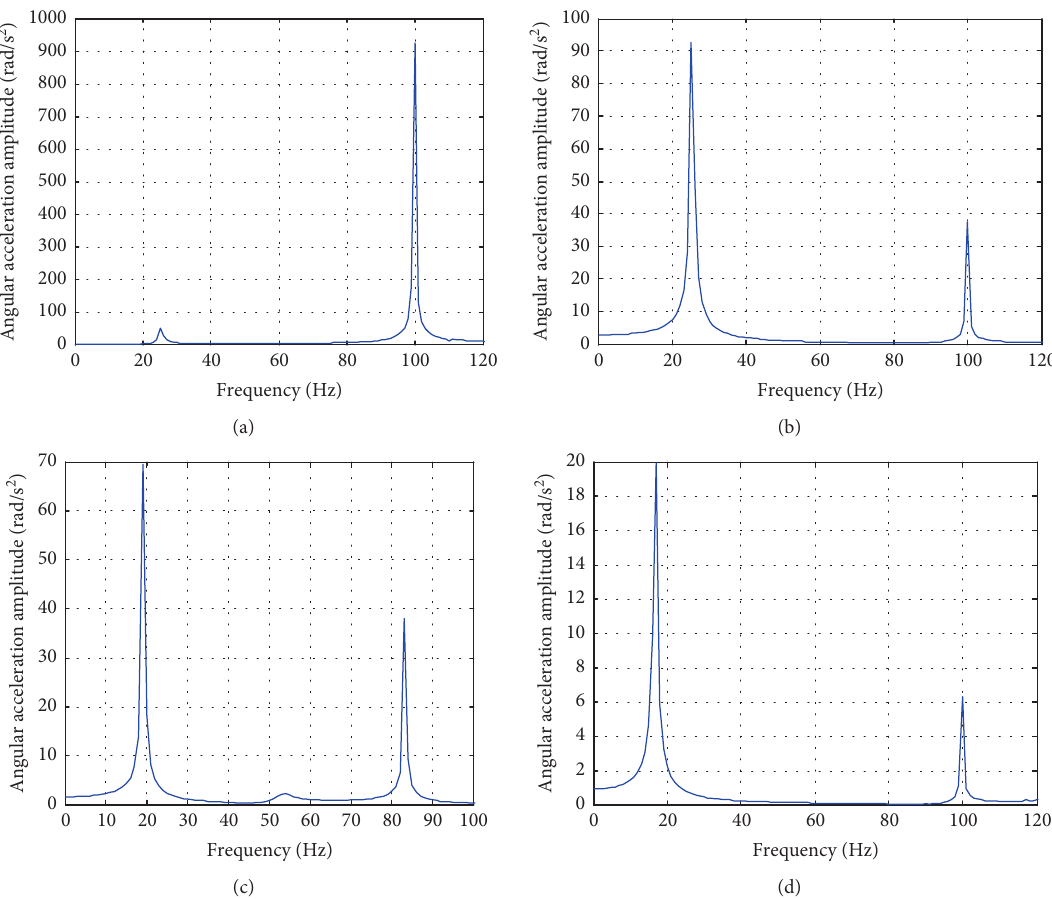
Figure 17: Spectra of J 8 and J 10 at 3000r/min of engine speed: (a) spectrum of J 8 and (b) spectrum of J 10 of DMF; (c) spectrum of J 10 of DMF with simple CPVA; (d) spectrum of J 10 of DMF with bifilar CPVA.